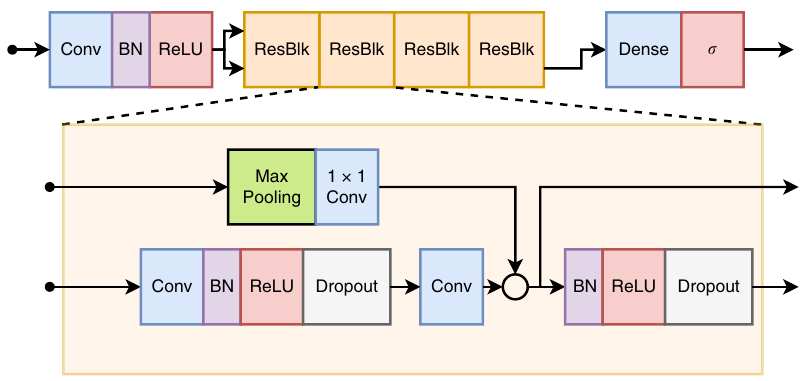
Fig. 3 (DNN architecture). The unidimensional residual neural network architecture used for ECG classi